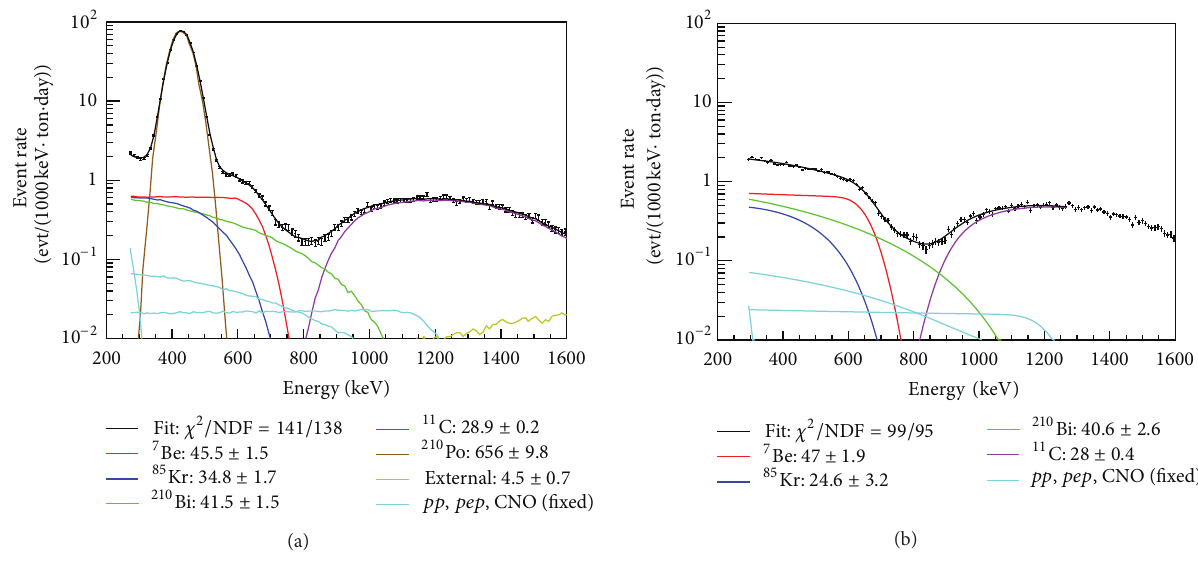
Figure 9: Examples of fitted spectra; the fit results in the legends have units [counts/(day ⋅ 100ton)]. (a): A Monte Carlo based fit over the energy region 270–1600 keV to a spectrum from which some, but not all, of the 𝛼 events have been removed using a PSA cut, and in which the event energies were estimated using the number of photons detected by the PMT array. (b): An analytic fit over the 290–1270 keV energy region to a spectrum obtained with statistical 𝛼 subtraction and in which the event energies were estimated using the total charge collected by the PMT array. In all cases the fitted event rates refer to the total rate of each species, independently from the fit energy window (from